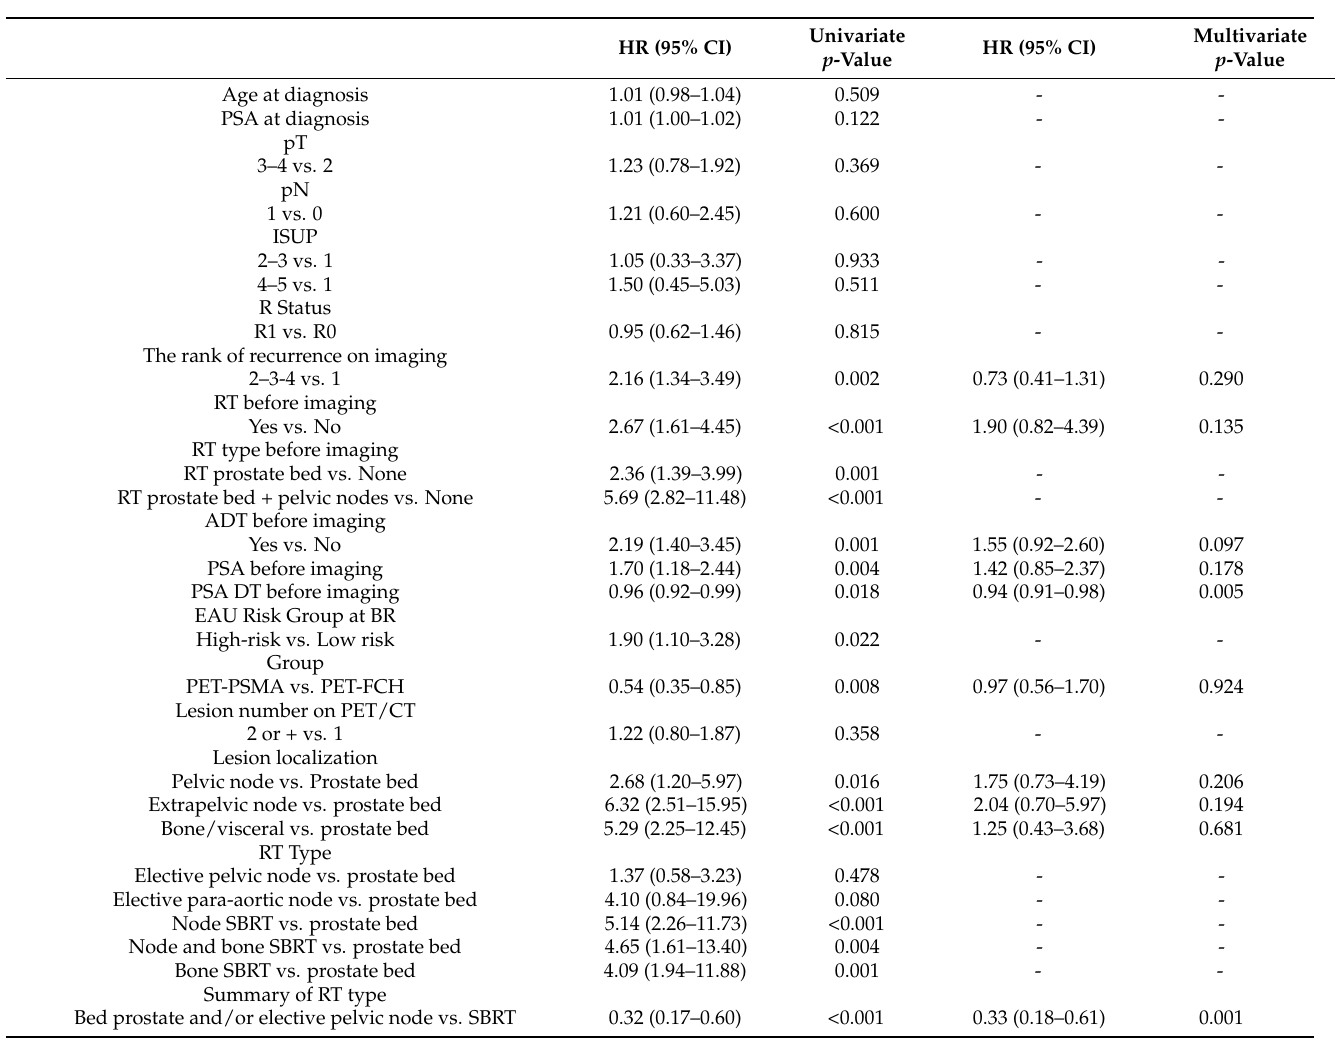
Table 6. Uni- and multivariate analyses of predictors of biochemical relapse after treatment.